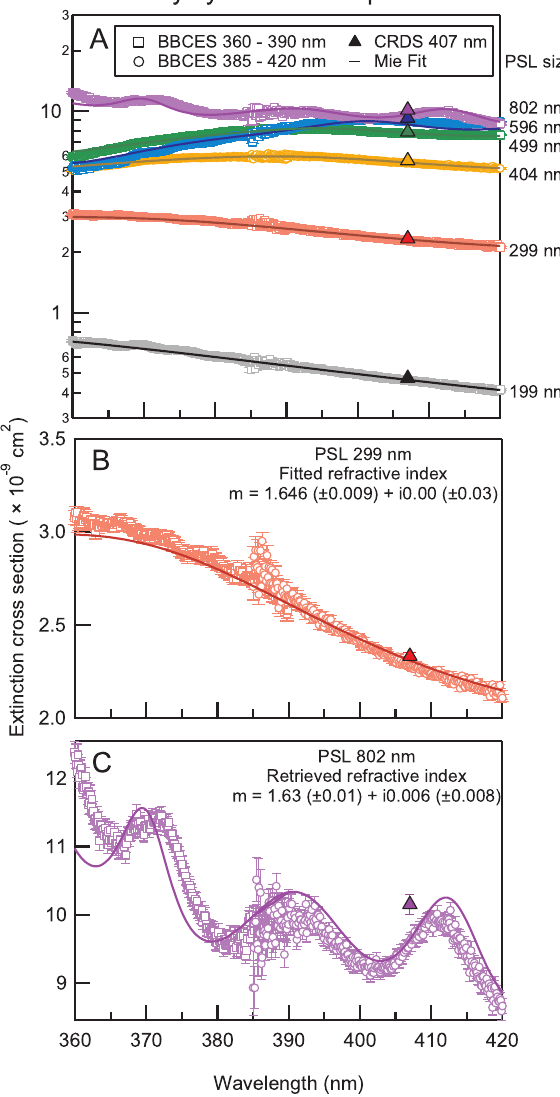
Fig. 3. (a) Extinction cross sections as a function of wavelength for 199–802nm diameter PSL measured with the BBCES 360–390nm (squares), BBCES 385–420nm (circles), and CRDS at λ = 407nm (triangles). The solid lines show the best Mie fit. (b) Expanded view of the 299nm PSL extinction cross section measurements and Mie fit. The retrieved complex refractive index is given in the upper right hand corner. (c) Similar expanded view for 802nm